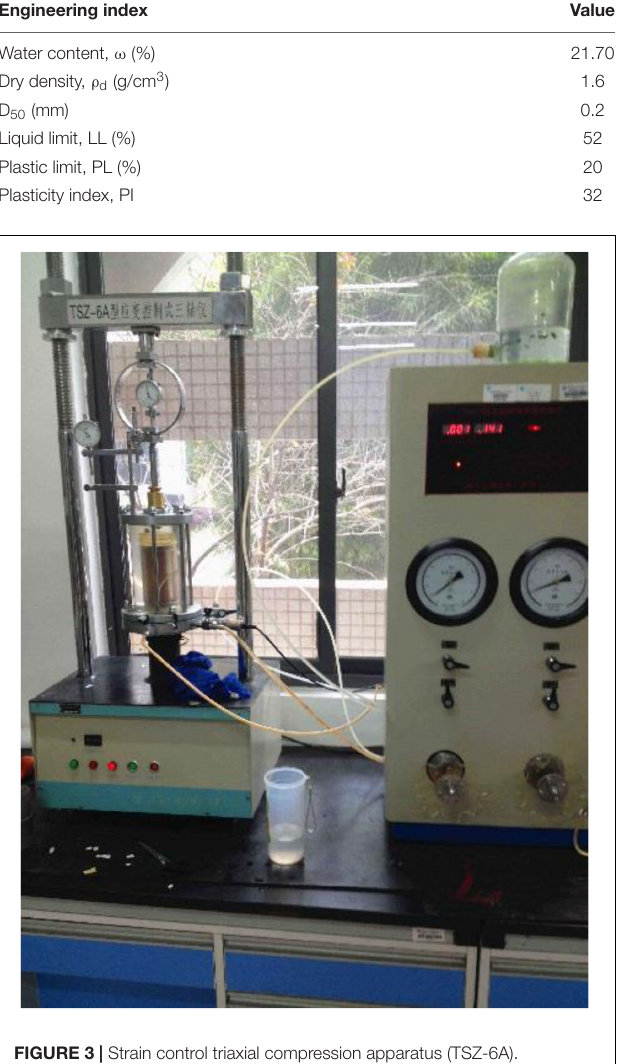
FIGURE 3 | Strain control triaxial compression apparatus (TSZ-6A).